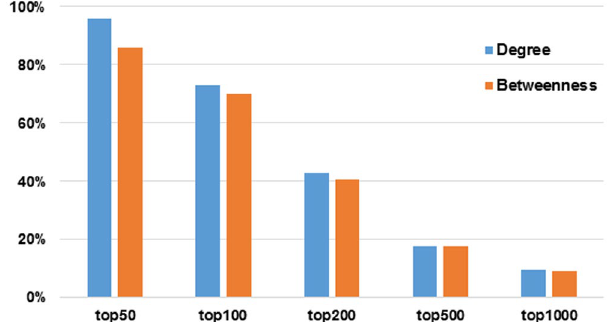
Figure 3. Topological properties of miRNA-regulated CePPIN. The ratios of miRNA targets in top 50, 100, 200, 500, 1000 nodes sorted by degree and betweenness centrality respectively.